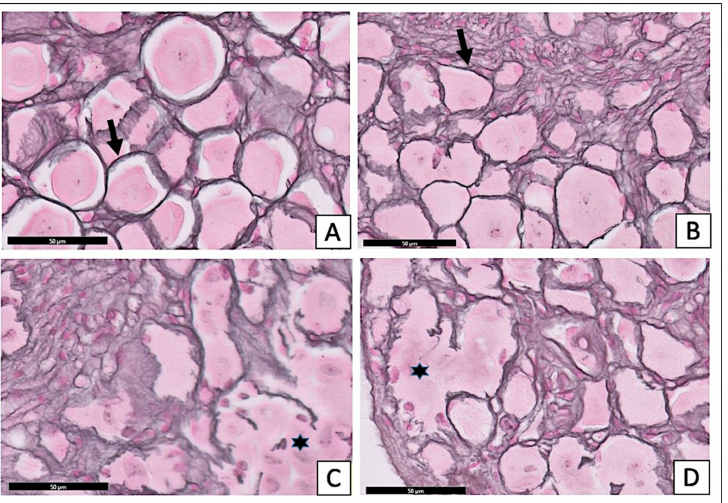
Figure 5. Effect of X. testudinaria extract on histopathological changes of DRG in streptozotocin (STZ)-induced diabetes in mice using reticulin stain: a photomicrograph of the dorsal root ganglia (DRG) of control group ( A ), X. testudinaria -only group ( B ), STZ-diabetic group ( C ), and STZ-diabetic on X. testudinaria -treated group ( D ). Arrows show reticular stroma and stars mark the distorted stroma, which give rise to the alveolar pattern. Reticulin stain was used and a scale bar 50 µ m.